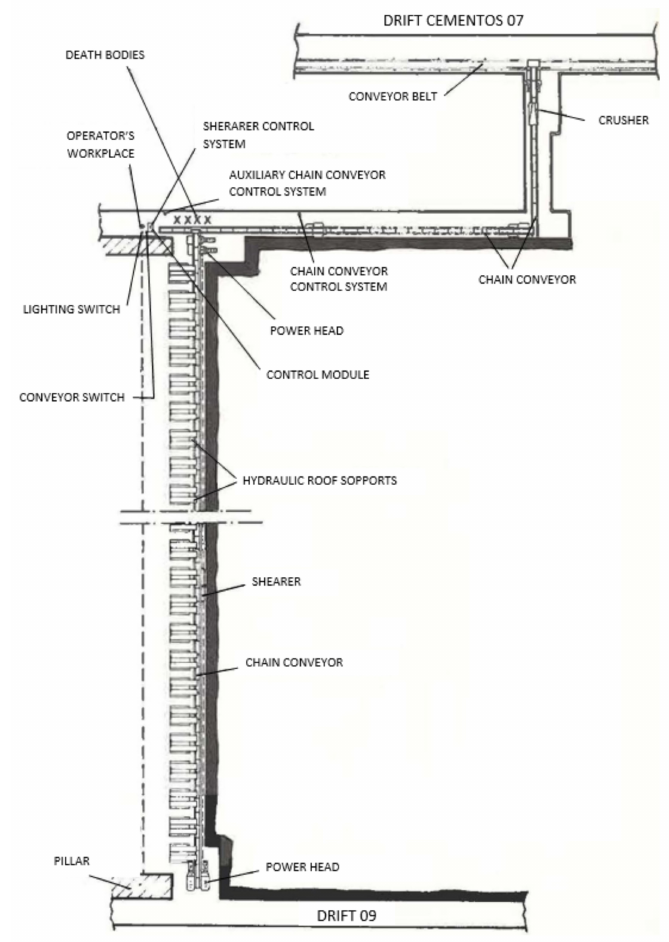
Figure 2. Detailed scheme of the